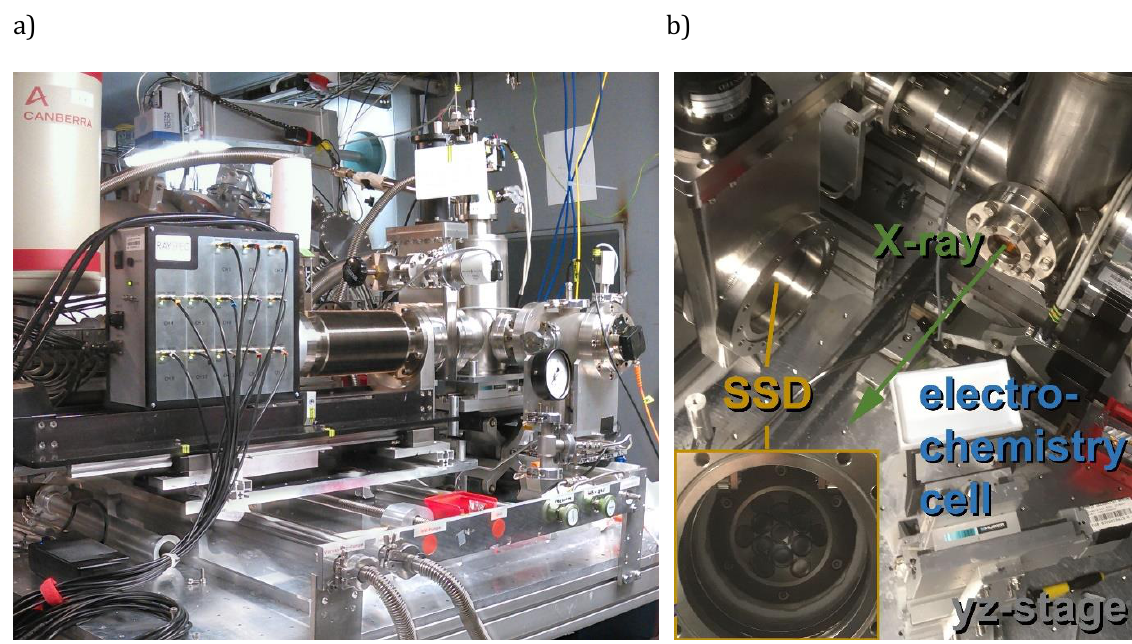
Figure 2: KMC-3 CryoEXAFS experimental station a) with cryogenic condition utilizing the 13- element Si-drift SSD (Rayspec) that is flanged to the cyrostat, the same SSD is used in b) to acquire data using an electrochemical cell, the I1 ion chamber and I2 photodiode have been removed for this purpose. Using the yz-stage, the electrochemical cell can be aligned with the X-ray beam. See also Figure